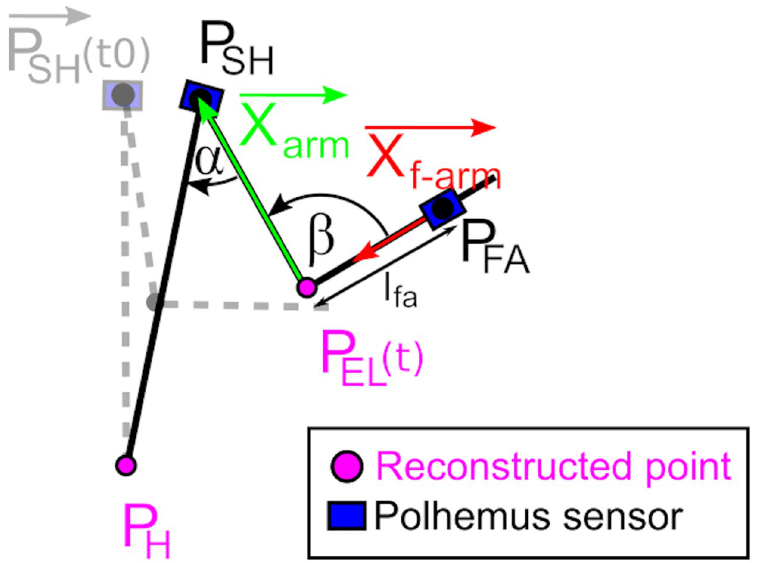
Fig 2. Schematic representation -projected in sagittal plane- of the shoulder elevation angle α and elbow flexion- extension β .